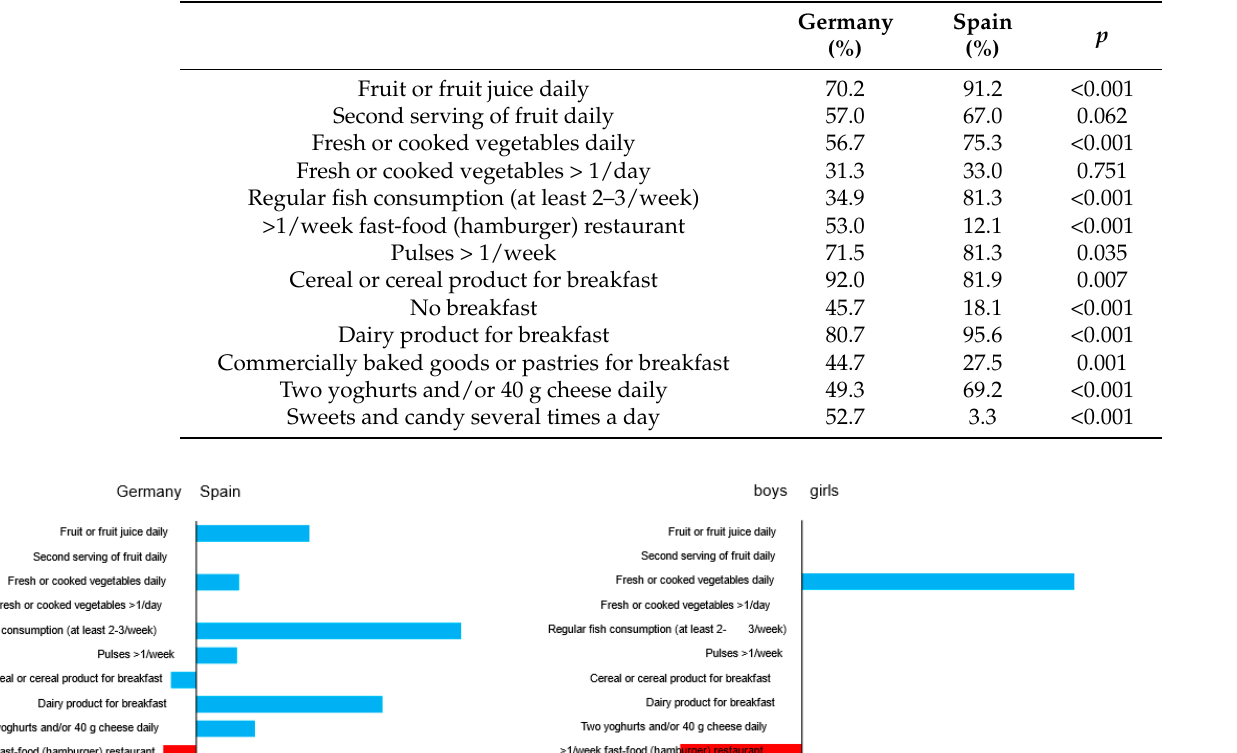
Table 3. KIDMED questions by country.